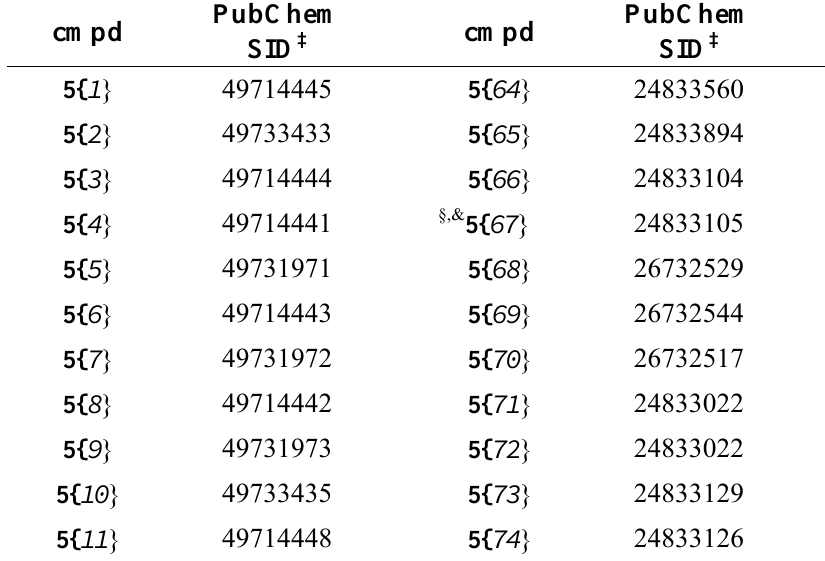
Cross reference guide for library members with the PubChem database (SID identification